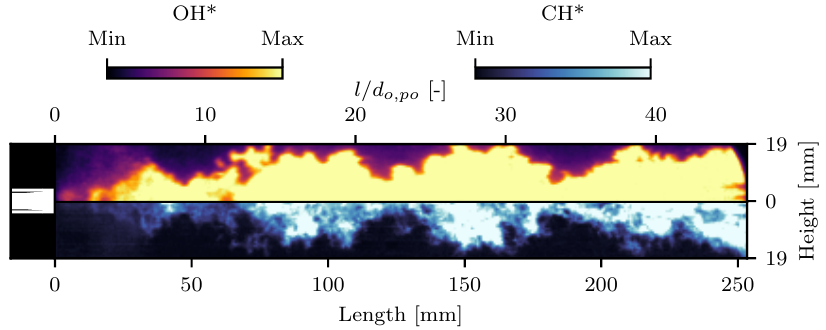
Figure 8. Instantaneous flame radiation imaging (OH*/CH*) of LP1.